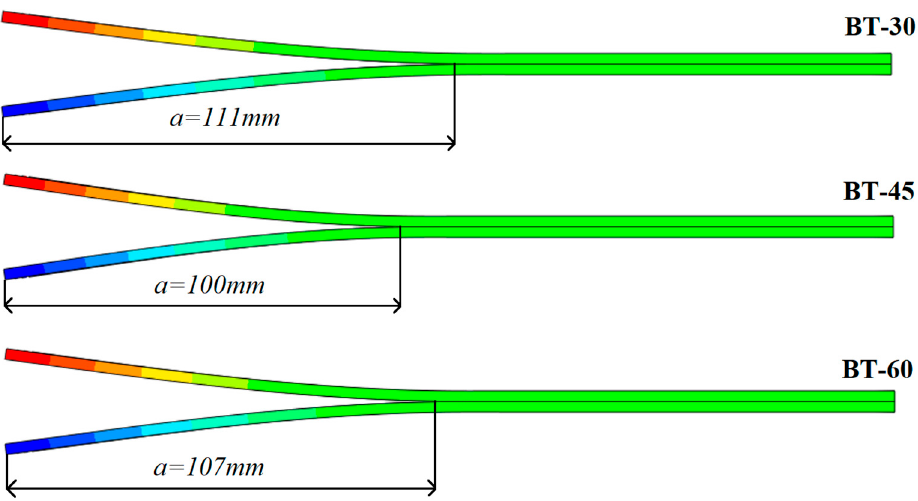
Figure 12. Total crack lengths obtained during the FE simulations conducted on different types of BT laminates.